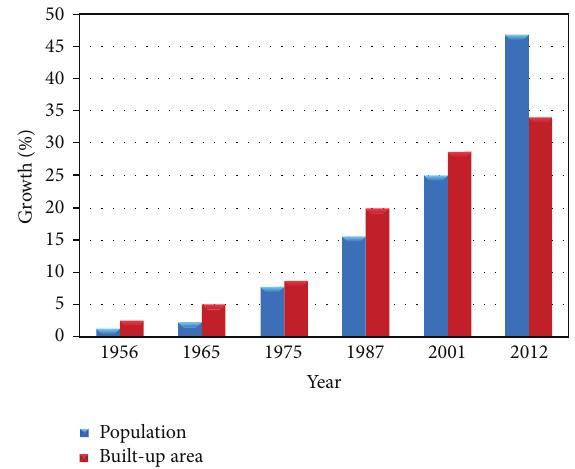
Figure 4: Population growth to area of built-up area ratio in Bandar Abbas city (1956–2012).